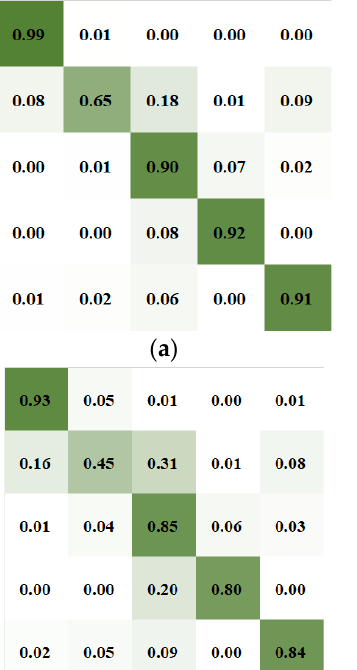
Table 6. Confusion matrix of Sleep-EDFX-SHHS dataset.